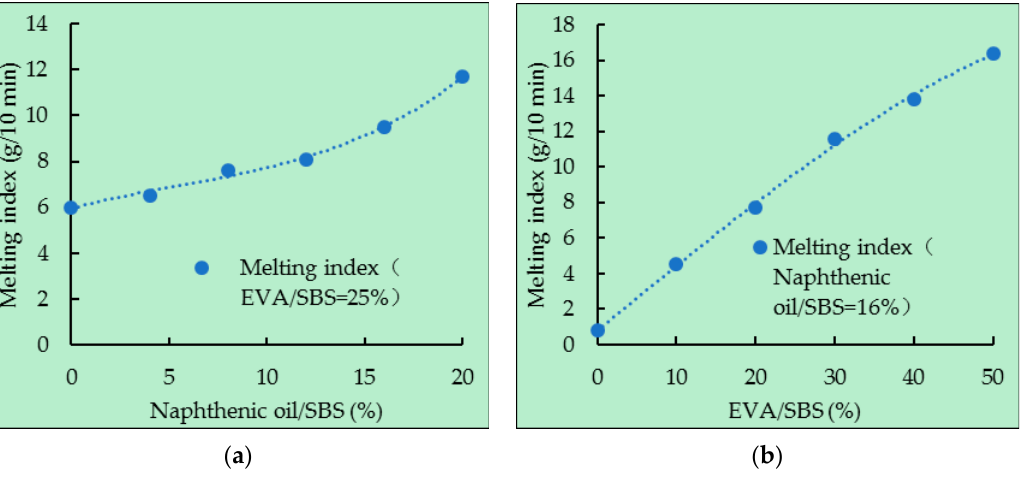
Figure 10. Melting index of different direct-to-plant SBS modifiers: (a) EVA/SBS = 25% and (b) naphthenic oil/SBS = 16%.